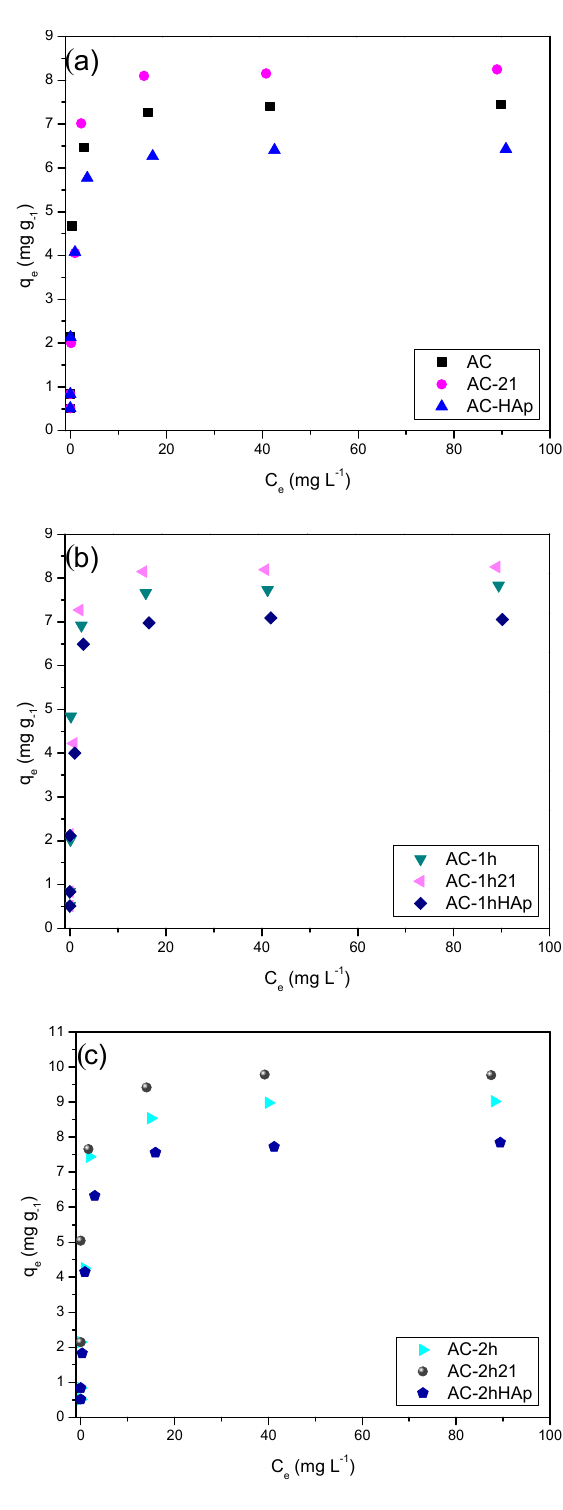
Figure 9. Adsorption isotherms of methylene blue on various carbon-based materials: ( a ) AC, AC-21, and AC-HAp; ( b ) AC-1h, AC-1h21, and AC-1hHAp; ( c ) AC-2h, AC-2h21, and AC-2hHAp, at 36 °C, pH 7, and initial dose of 0.1 mg of each adsorbent.